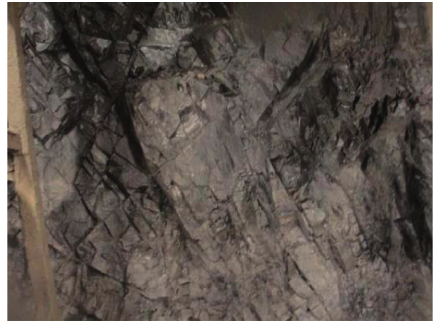
Figure 1: Hard cataclastic surrounding rock in excavation face.